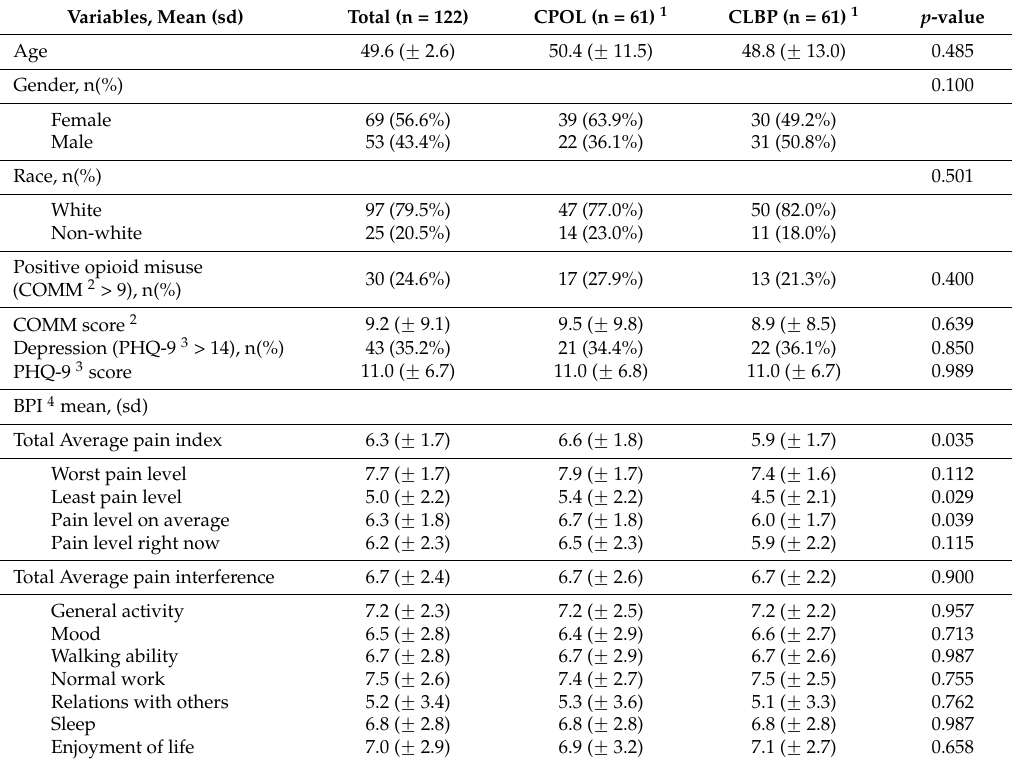
Table 1. Characteristics of family medicine pain clinic patients, n = 122.